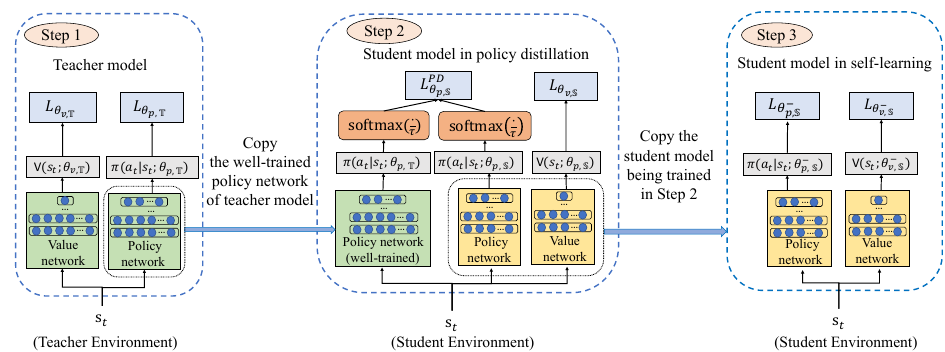
Figure 1. Overview of the policy distillation design with EONs.